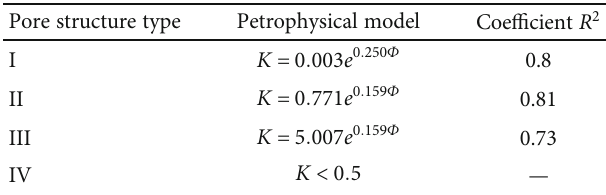
Figure 13: The relationships between the D of di ff erent petrophysical properties: (a) D versus air porosity; (b) D versus air permeability; (c) D ; (e) D versus FZI; (f) D versus RQI. versus SC; (d) D versus r apex Table 5: Permeability prediction models of 4 pore structures